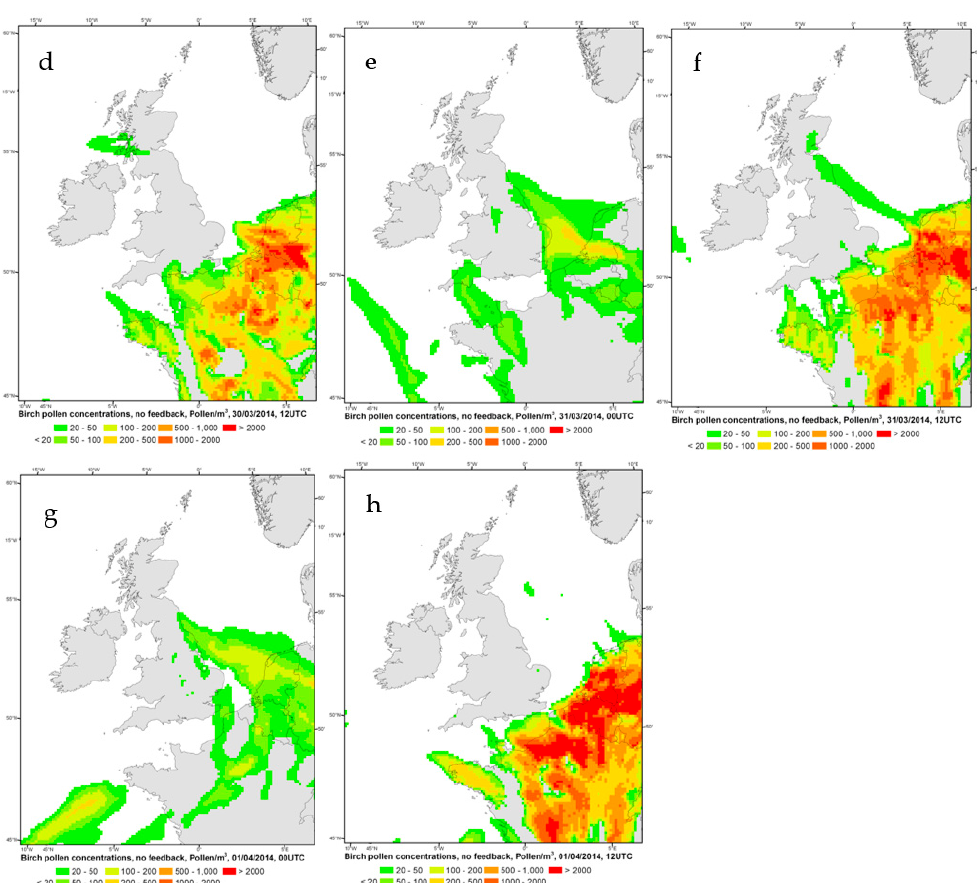
Figure 4. Calculated birch pollen concentration (pollen/m 3 ) without UK emission and without radiation feedback during four days ( a – h ) 29 March–1 April 2014 with a 12-hour interval going from the top left to lower right.